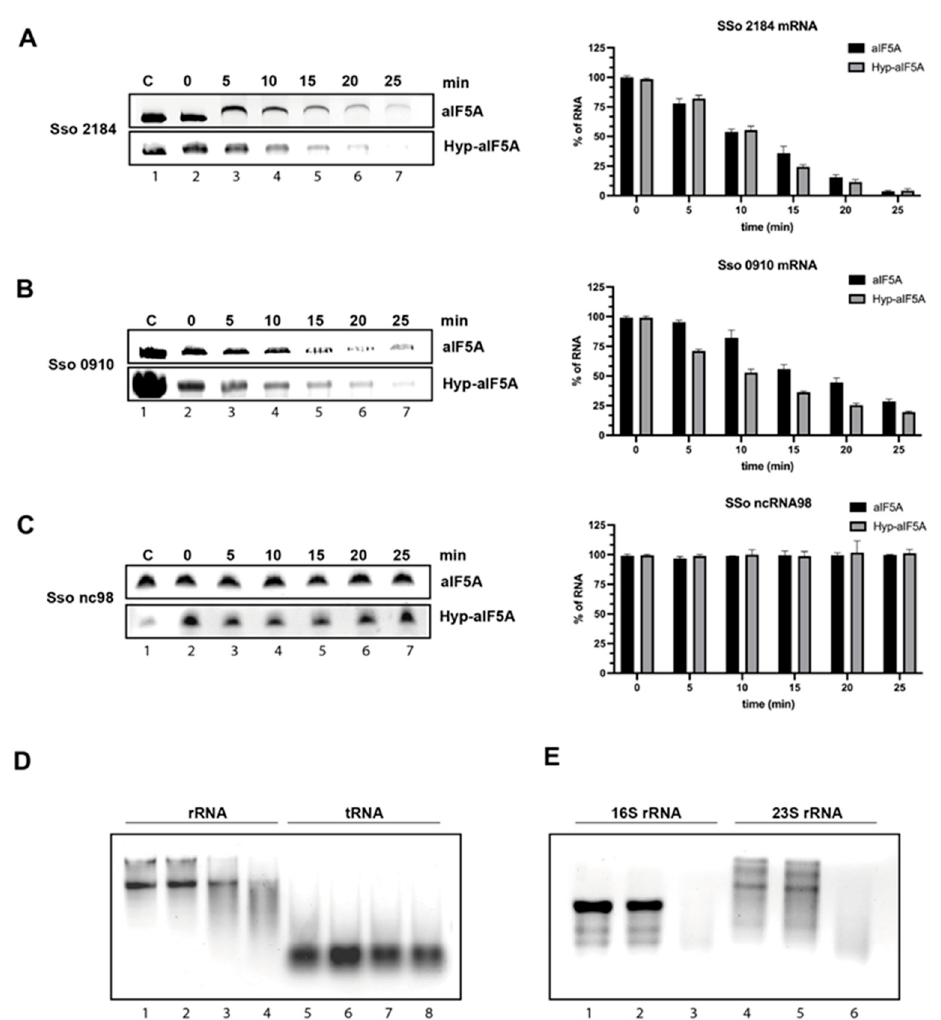
Figure 2. aIF5A shows differences in its ribonucleolytic activity based on different RNA classes: Degradation assay of S. solfataricus 2184 mRNA ( A ) 0910 mRNA ( B ) or ncRNA 98 ( C ) with re- combinant N-His-aIF5A (produced in E. coli , without hypusination) and Hyp-aIF5A (produced in S. solfataricus and hypusinated). Lane 1, RNAs incubated for 25 min at 65 ◦ C in absence of proteins; lanes 2–7, time-course of degradation of RNAs with N-His-aIF5A (upper panel) and Hyp-aIF5A (lower panel) for 25 min at 65 ◦ C. ImageLab software were used to quantify the RNA and the signal of the 0 min sample was set to 100%. The graphical representation shows the average of three independent experiments; the error bars represent standard deviations. ( D ) Degradation assay of total rRNA and tRNA with recombinant N-His-aIF5A. Total rRNA (lane 1) or total tRNA (lane 5) without incubation and in the absence of protein; total rRNA (lane 2) or total tRNA (lane 6) incubated for 30 min at 65 ◦ C in the absence of protein; total rRNA (lane 3) or total tRNA (lane 7) incubated for 30 min at 65 ◦ C in presence of 100 pmol (lane 3 and 7) or 200 pmol (lane 4 and 8) of N-His-aIF5A. ( E ) Degradation assay of 23S and 16S rRNA with recombinant N-His-aIF5A. 23S (lane 1) and 16S (lane 4) without incubation and in the absence of protein; 23S rRNA (lane 2) or 16S tRNA (lane 5) incubated for 30 min at 65 ◦ C in the absence of protein; 23S rRNA (lane 3) or total tRNA (lane 6) incubated for 30 min at 65 ◦ C in presence of 100 pmol of N-His-aIF5A.